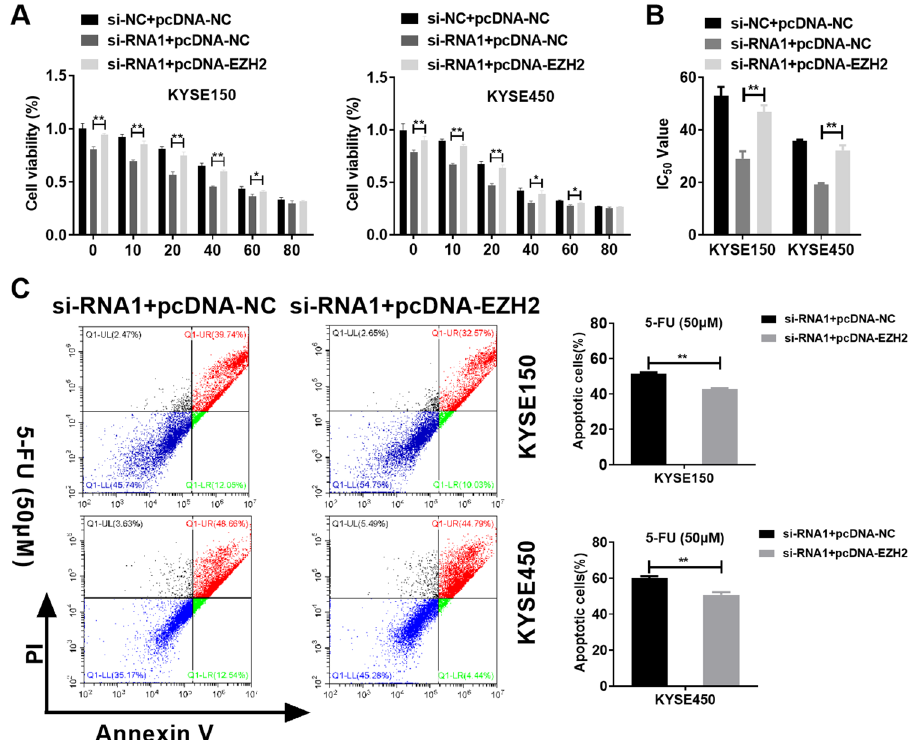
Figure 7. Overexpression of EZH2 abolished the role of SNHG6 silencing on EC cells sensitivity to 5-FU. ( A ) Role of si-RNA1 and pcDNA-EZH2 co-transfection in cells viability of EC cells. ( B ) Role of si-RNA1 and pcDNA-EZH2 co-transfection in IC 50 of 5-FU to EC cells. ( C ) Role of si-RNA1 and pcDNA-EZH2 co-transfection in apoptosis of EC cells. *P < 0.05; **P < 0.01 (Two-way Student’s